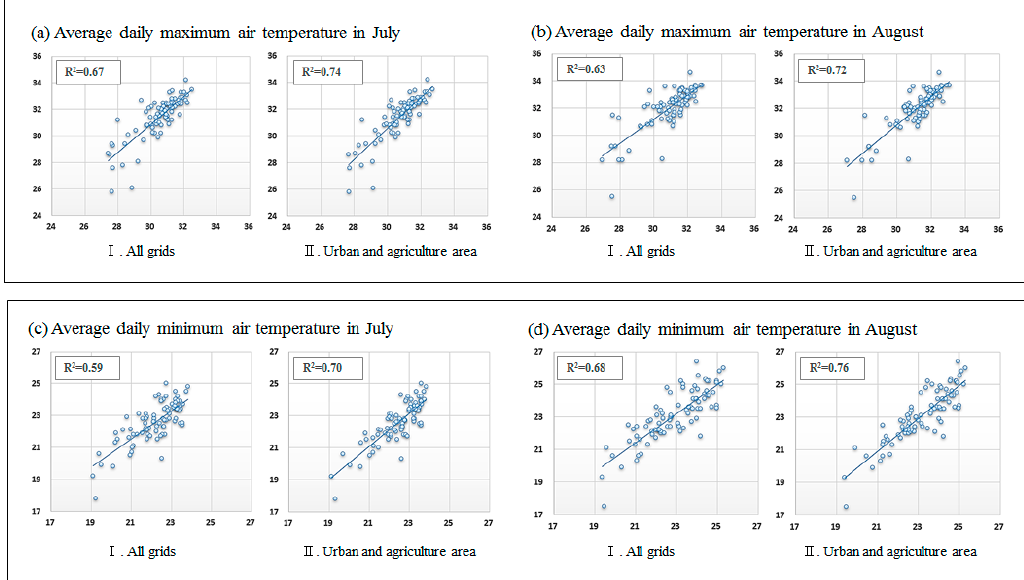
Figure 12. Correlations among daily maximum temperature, overall grids (I), and urban and agricultural areas (II). The first row pertains to the daily maximum temperature, whereas the second row pertains to the daily minimum temperature. ( a ) Average daily maximum air temperature in July; ( b ) Average daily maximum air temperature in August; ( c ) Average daily minimum air temperature in July; ( d ) Average daily minimum air temperature in August. ( a – d ) are the average daily temperature in summer.